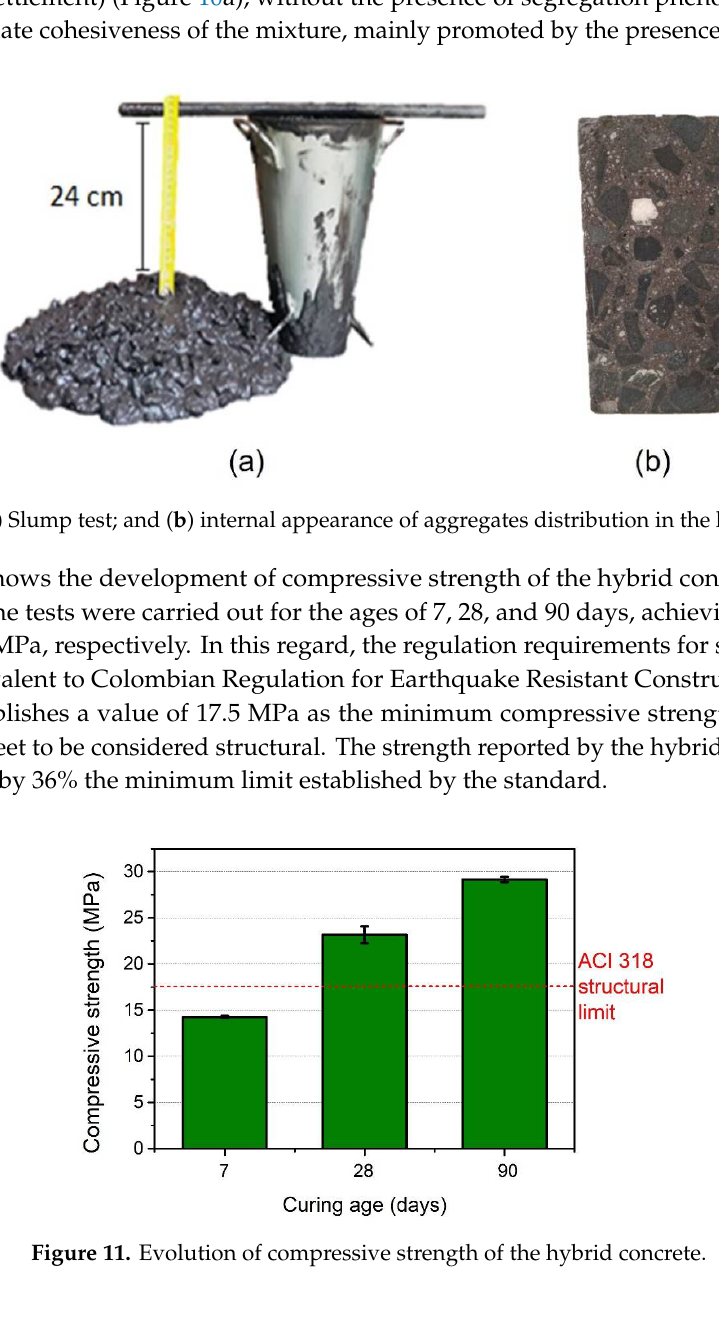
Figure 11. Evolution of compressive strength of the hybrid concrete. Table 6. Physical properties of the hybrid concrete (28 days). Physical Properties Density